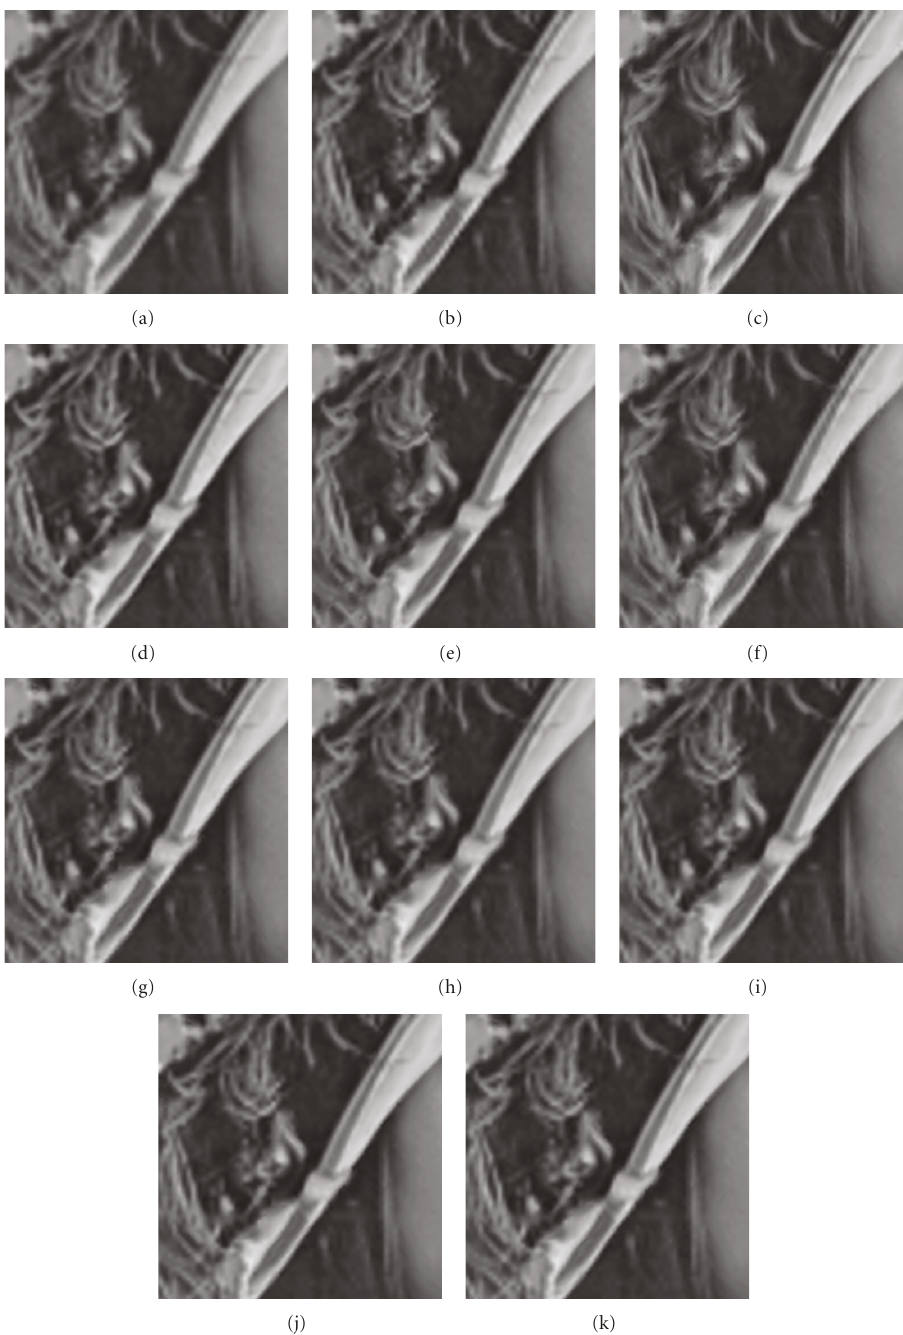
Figure 15: Portions of resolution enhanced “Lena” image (downsampled by averaging) by (a) bilinear; (b) bicubic; (c) edge-directed method ( M = 8) [12]; (d) ICBI [20]; (e) LMMSE-based method ( ζ = 1, ξ = 1 . 5) [17]; (f) SAI ( λ = 0 . 5) [18]; (g) NN-based method [16]; the proposed method utilized (h) bilinear kernel and (i) bicubic kernel without edge enhancement; (j) bilinear kernel and (k) bicubic kernel with edge